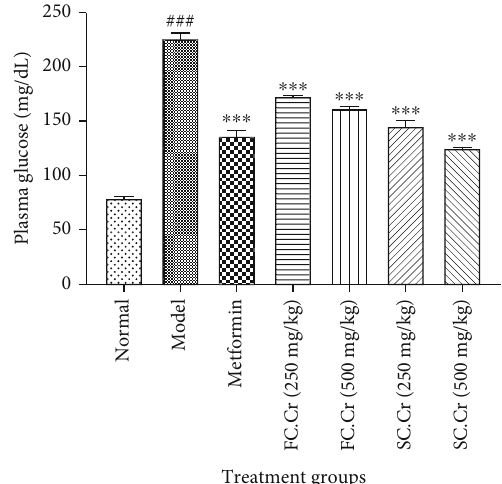
Figure 2: E ff ects of FC.Cr. and SC.Cr. on body weights in HFD- STZ-induced rats with established diabesity. The rats were induced with HFD-STZ to mimic diabesity. FC.Cr. and SC.Cr. were administered at 250 mg/kg and 500mg/kg after three weeks till the end of the study duration. Body weights were measured on a daily basis, and the fi nal weights were compared with the standard drug metformin. The values are expressed as the mean of six animals in a group. Statistical analysis is performed with one- way ANOVA followed by Tukey ’ s test. All the groups are compared with the HFD-STZ group, while the HFD-STZ group is compared with the normal group. The results are considered signi fi cant ( ∗ ) if P < 0 : 05 ( ∗∗ ) and if P < 0 : 01 and highly signi fi cant ( ∗∗∗ ) if P < 0 : 001 .